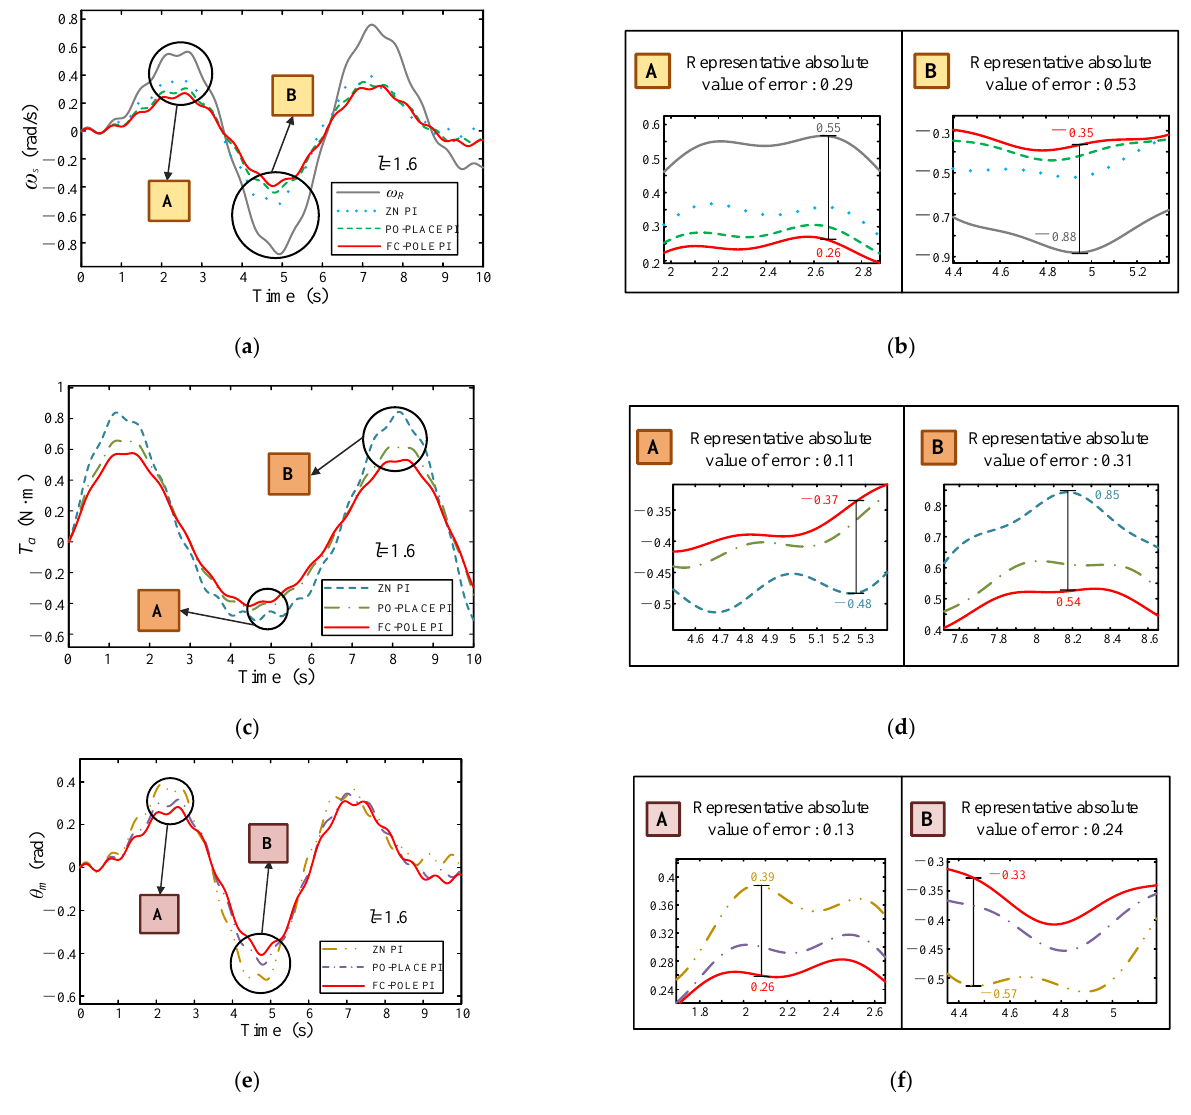
Figure 7. Output curve of double flexible body under parameter 2: ( a ) system rotation frequency diagram; ( b ) local amplification diagram of rotation frequency; ( c ) system torque diagram; ( d ) local amplification diagram of system torque; ( e ) system output angle diagram; ( f ) local magnification of system output